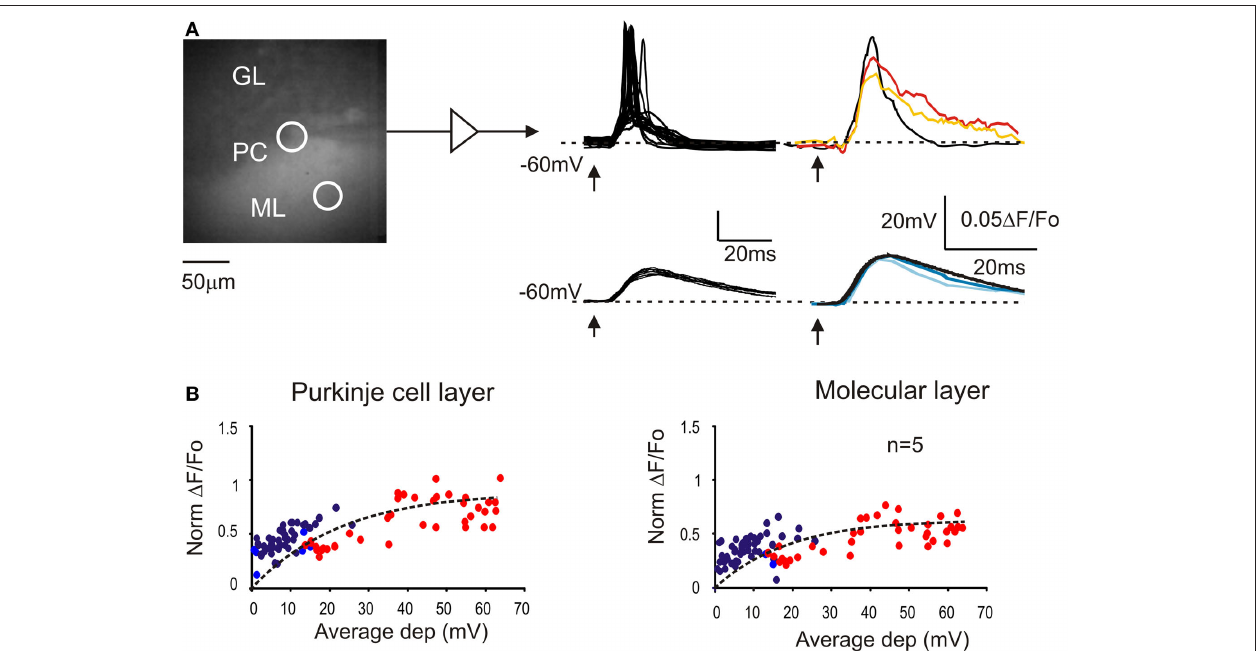
FiGure  | The relationship between VSD signals and Purkinje cell activity. (A) Image of a stained cerebellar slice obtained by collecting background epifluorescence showing Granular layer, Purkinje cell layer and Molecular layer during a whole-cell recording from a Purkinje cell. The patch pipette appears as a shadow (since is not filled with dye molecules). Red and orange circles indicate the ROIs corresponding to the recorded PC and its dendritic arborization, from which the VSD signals were measured. Excitatory postsynaptic potential (EPSPs) and EPSP-spike complexes were obtained at low and high stimulation intensity, respectively (arrows indicate the stimulus time). Average electrical signals (black traces) are compared with average